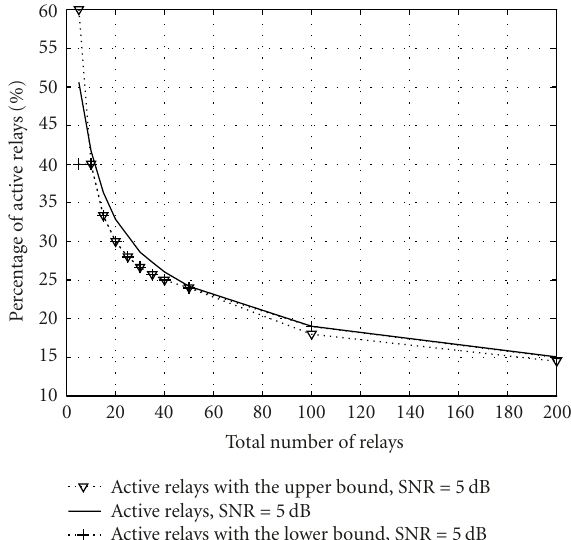
Figure 6: Expected number of active relays (in %) of a multiple relay channel with transmit SNR = 5dB, under Rayleigh fading. The number of relays that optimizes the upper and lower bounds are shown for comparison.